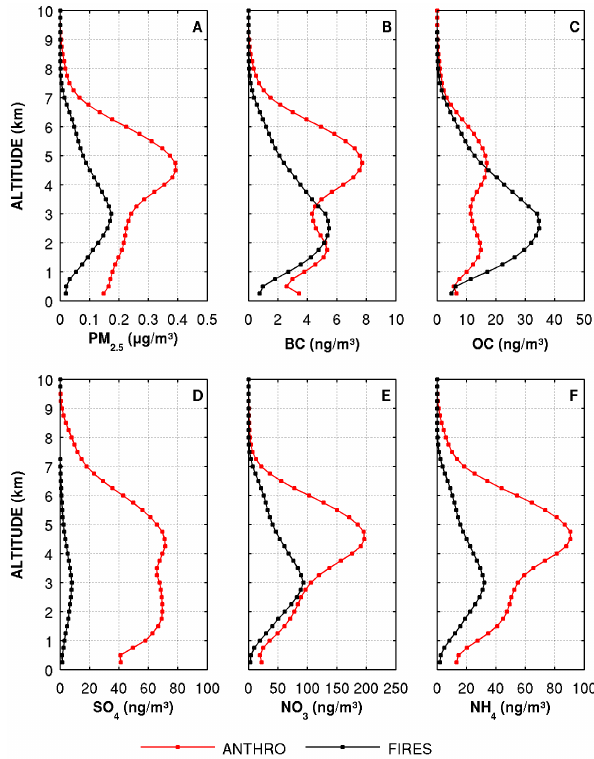
Figure 12. Modeled vertical profiles of enhancements in (a) PM 2 . 5 , (b) BC, (c) OC, (d) SO = , (e) NO − , and (f) NH + PM 2 . 5 , due to 4 3 4 anthropogenic (red) and fire (black) emissions within the WRF- Chem model domain, averaged in the Arctic (latitude > 66 . 6 ◦ N) and over the period from 00:00UTC 8 April 2008 to 00:00UTC 12 April